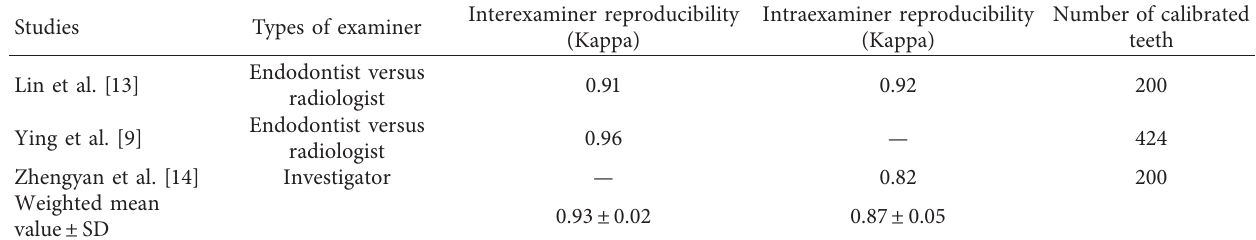
Table 1: Weighted means values for both inter- and intraexaminer reproducibility.